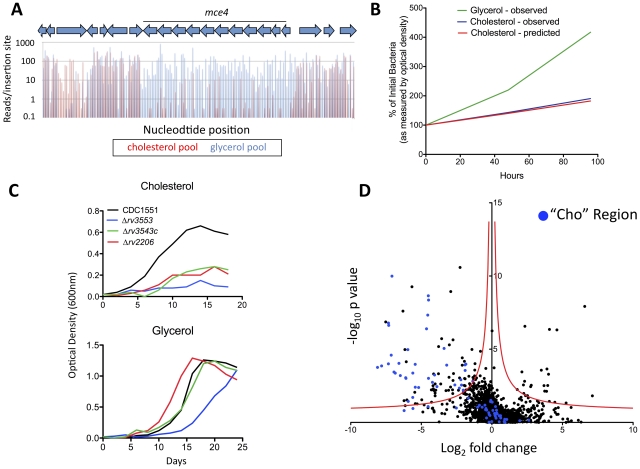
Genes required for growth on cholesterol.(A) Mce4 mutants are specifically underrepresented in the cholesterol-grown pool. Transposon libraries grown for 12 generations in media with either glycerol or cholesterol as a primary carbon source were compared by deep sequencing. Normalized sequence reads for individual insertions sites throughout the Mce4 operon are shown following growth in glycerol (blue) and cholesterol (red). The average underrepresentation of Mce4 mutants in the cholesterol-grown pool corresponds to a predicted 31% growth disadvantage per generation. (B) The number of sequence reads per TA provides an accurate estimate of relative growth rates. The experimentally determined growth curves of a Mce4 deletion mutant in the indicated media are compared to the growth rate of Mce4 mutants predicted in panel A. Log phase growth is plotted as percentage of initial bacterial number. (C) Mutants predicted to be required for cholesterol utilization display the predicted phenotypes. Transposon mutants were grown in minimal media with the indicated primary carbon sources and growth was monitored by optical density. This experiment was repeated three times with similar results. (D) Identification of genes that are differentially required for growth. For each gene, the ratio of normalized sequence reads per insertion site (cholesterol pool/glycerol pool) is plotted on the x-axis (“fold change”). Y-axis represents the significance of each of these changes in representation (p value). A hyperbolic function was used to define genes that were differentially represented. The asymptotes of these curves are 0 for the log2 fold change and −0.07 for the log10 p value. Genes containing fewer than two TA sites were excluded from the analysis. Genes in blue represent those within the predicted cholesterol region.